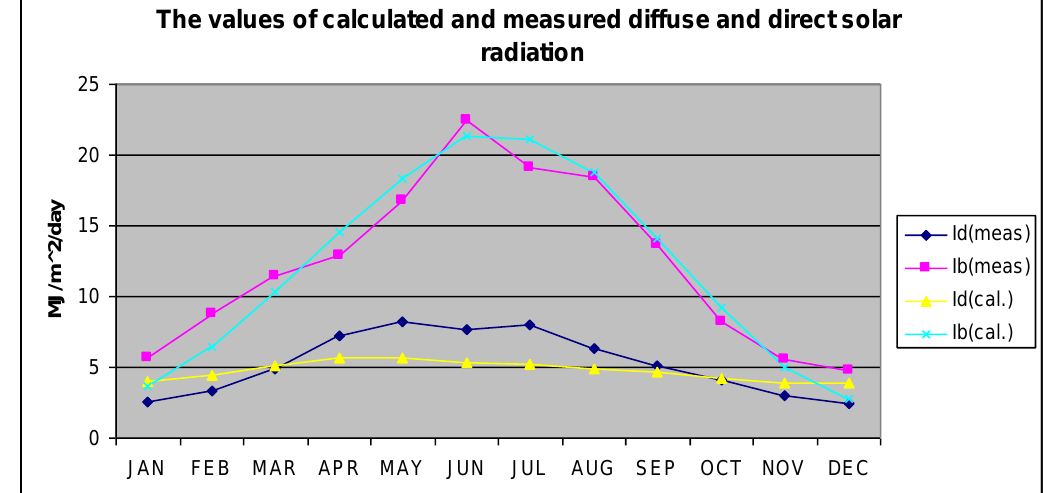
Fig. 7: Calculated and measured values of diffuse and direct solar